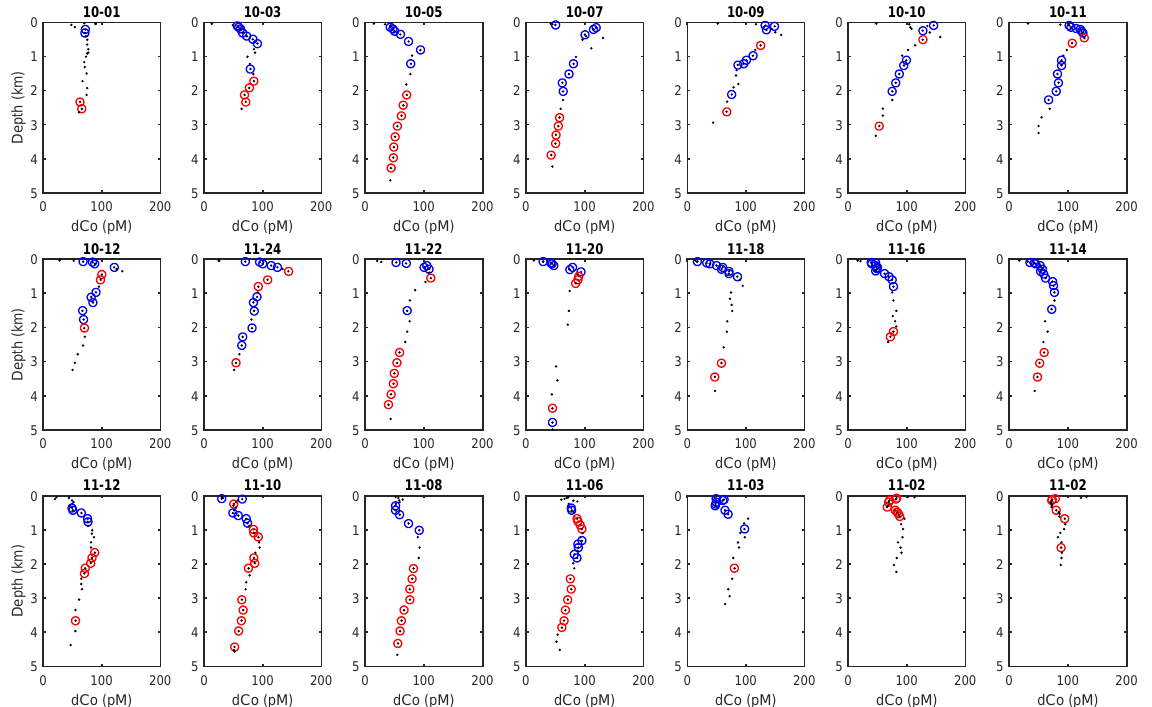
Figure 5. Vertical profiles of dissolved cobalt (pM) versus depth (m) from the North Atlantic GA03/3_e section (black symbols) with stations listed above by expedition year (first two digits for USGT10 and 11) and station number (last two digits), separated by a dash. Blue and red overlaid circles represent positive and negative slopes by linear regression ( − 0.7< r >0.7), to indicate phytoplankton/remineralization and scavenging processes,